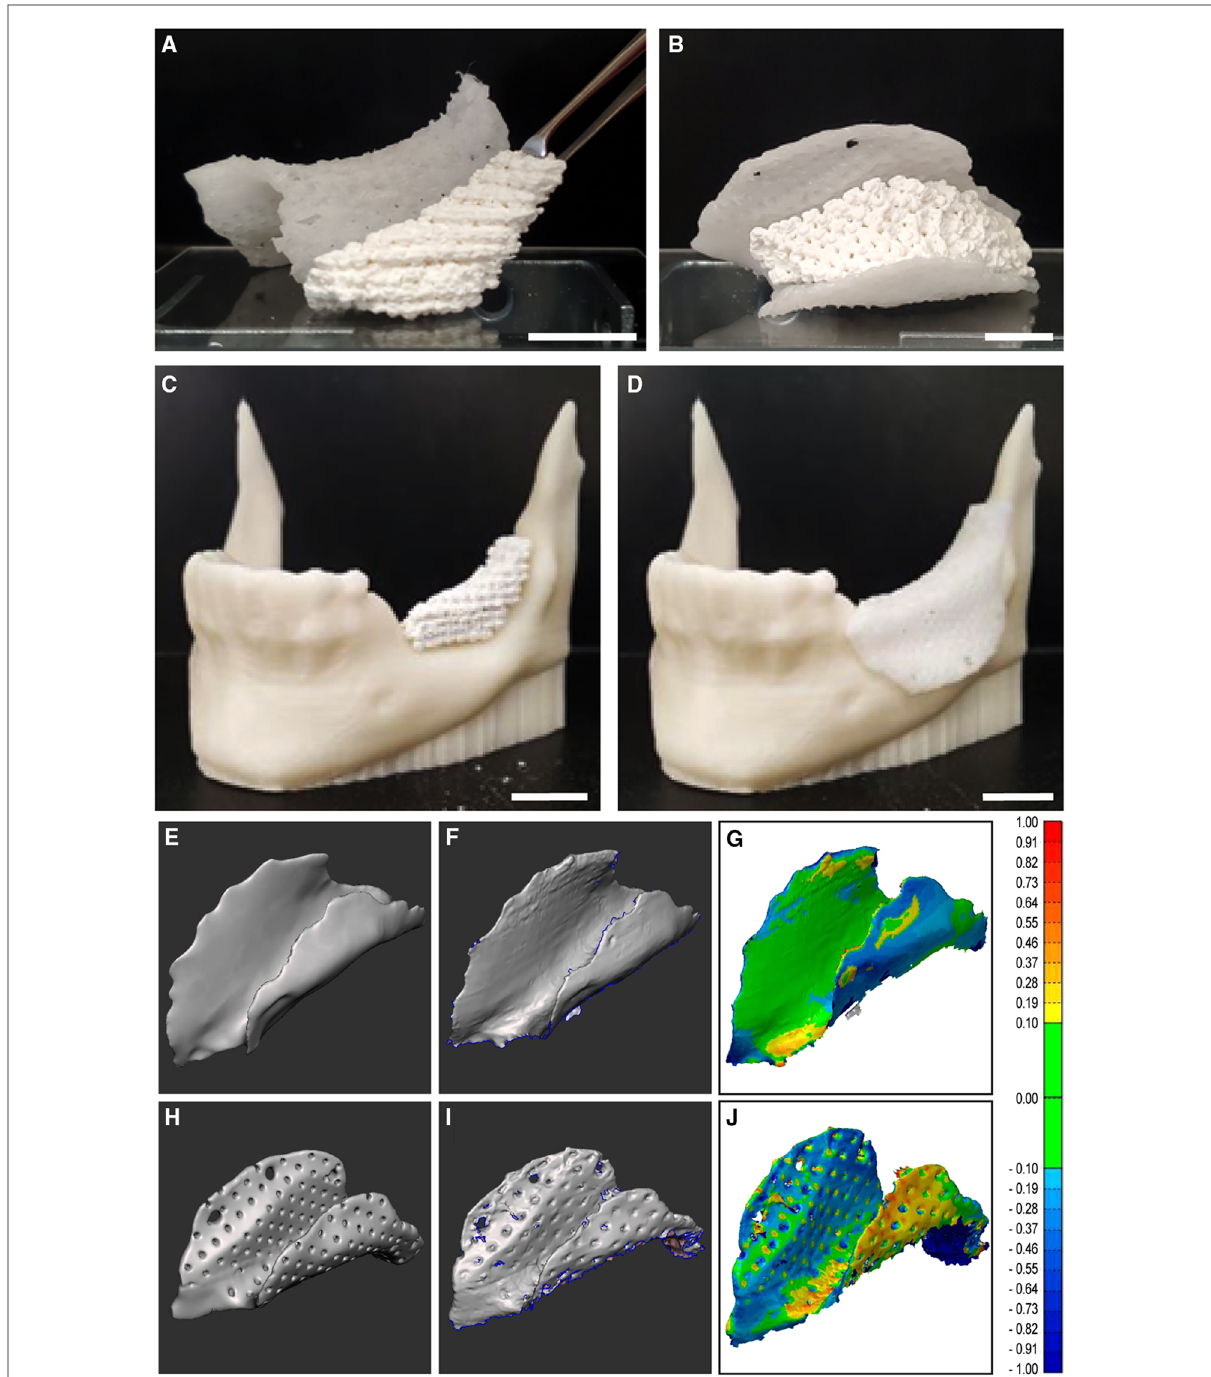
FIGURE 4 Assembling of the core, cover and their computational fi tting evaluation. ( A – D ) Assembly of the printed devices. ( A ) Osteoconductive porous TCP/HA core next to a PCL cover. ( B ) The TCP/HA core fi tted into its PCL cover as for surgical placement. ( C ) The TCP/HA core placed in a model of mandibular defect, 3D printed with thermoplastic acrylonitrile butadiene styrene (ABS) polymer. ( D ) The PCL porous cover placed over the bioceramic core, on the ABS plastic model of the mandibular defect. ( E – J ) Analysis of the device cover ’ s spatial deviation from its initial CAD. ( E,H ) CAD of compact and porous cover models, respectively. ( F,I ) Corresponding virtual equivalents of the printed objects, obtained by 3D scanning. ( G,J ) The results of the subtraction of one shape from the other (color coded for the amplitude of difference on the right-side scale, in mm). See also Supplementary Figure S2 for additional views. Scale bars: ( A,C,D ), 15 mm; ( B ), 10